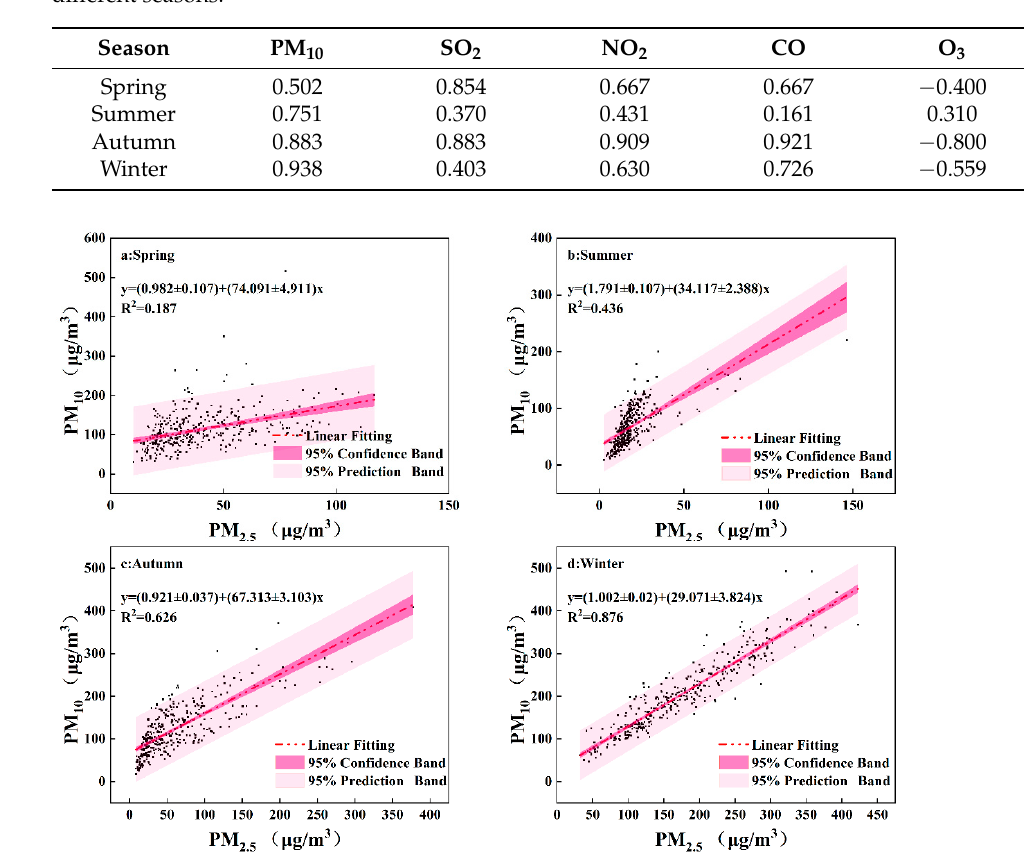
Figure 10. The linear relationship between PM 2.5 and PM 10 in terms of daily ( a ) and monthly ( b ) mean concentrations. Table 5. Spearman’s correlation coefficients between PM 2.5 and five other pollutants in different seasons.